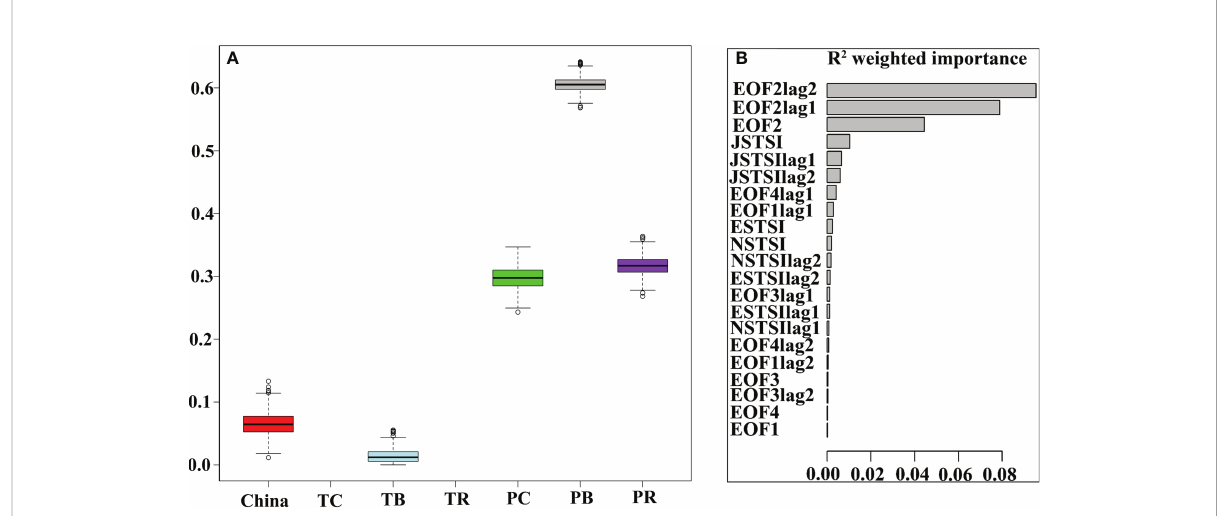
FIGURE 5 (A) Model performance (goodness-of- fi t) for 1000 runs of gradient forest for chub mackerel abundance. (B) Gradient forest analysis shows the weighted importance of regional TSI and modes of EOFs. (CC, Chinese catch; TC, TWC catch; TB, TWC biomass; TR, TWC recruitment; PC, Paci fi c catch; PB, Paci fi c biomass; PR, Paci fi c recruitment). Suf fi xes lag1 and lag2 represent time lags of 1 and 2 years,